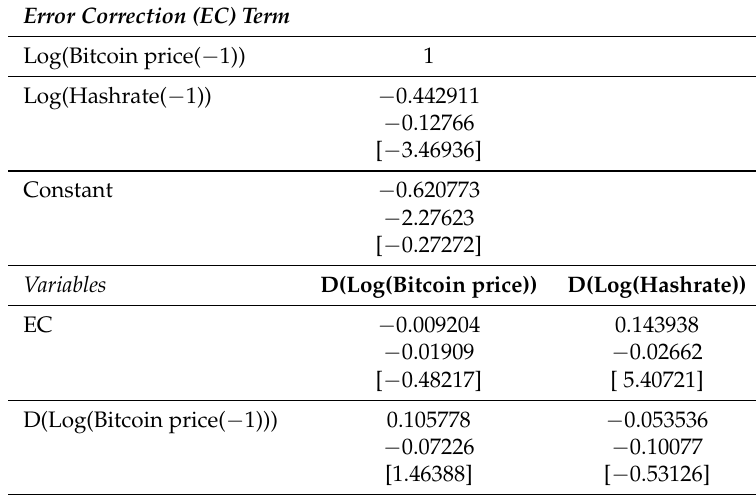
VECMX(6) for Log(Bitcoin price), Log(Hashrate) and Log(Transaction fees), with Log(transaction volume), Log(Google), and Log(Transaction fees) as exogenous variables. Second sample: